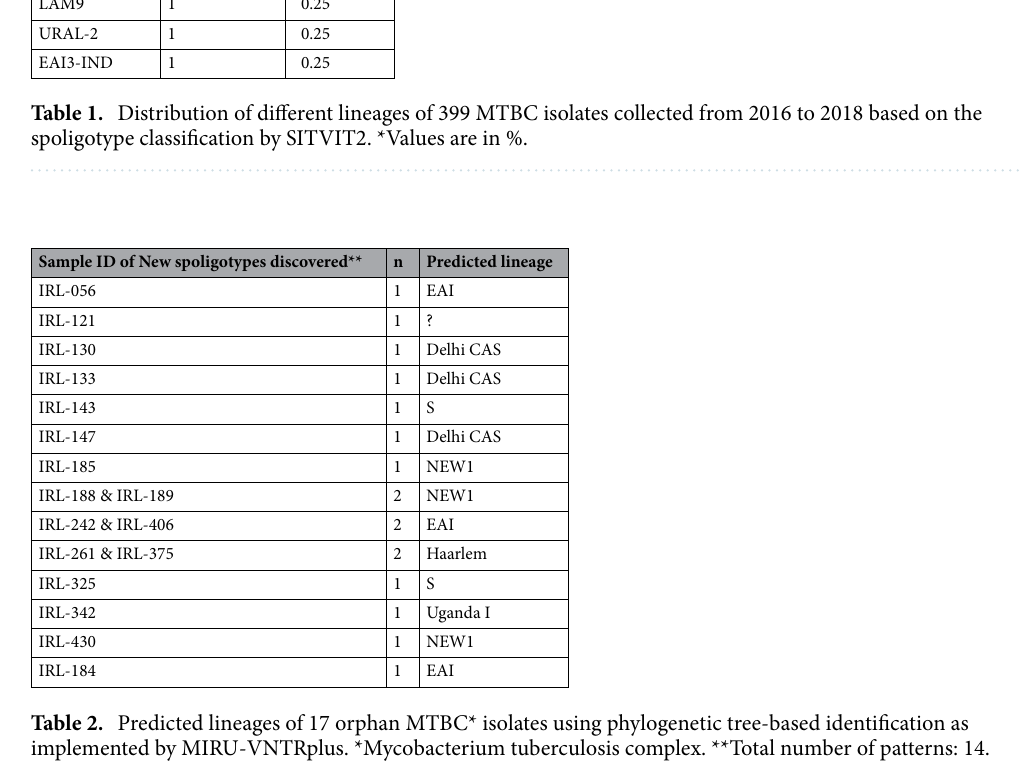
Table 2. Predicted lineages of 17 orphan MTBC* isolates using phylogenetic tree-based identification as implemented by MIRU-VNTRplus. *Mycobacterium tuberculosis complex. **Total number of patterns: 14.